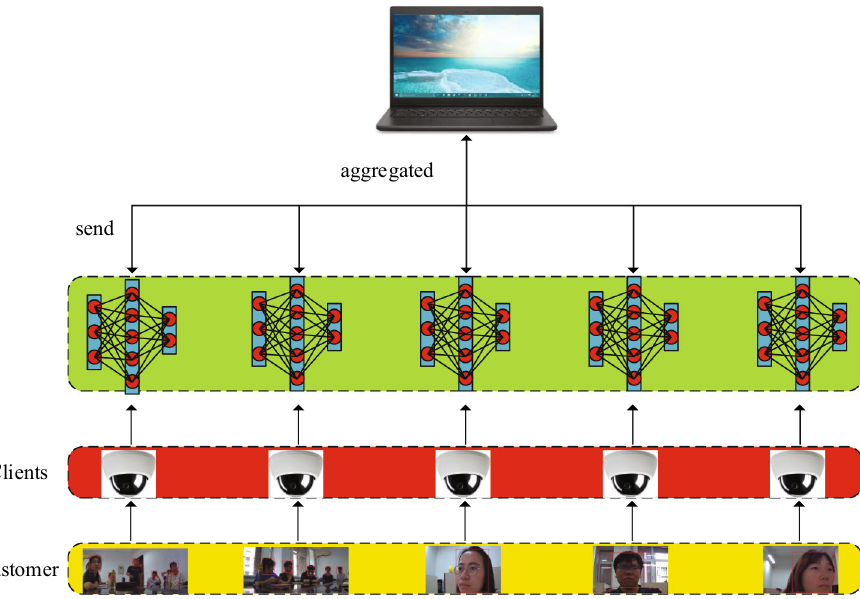
Fig. 3 Server and client